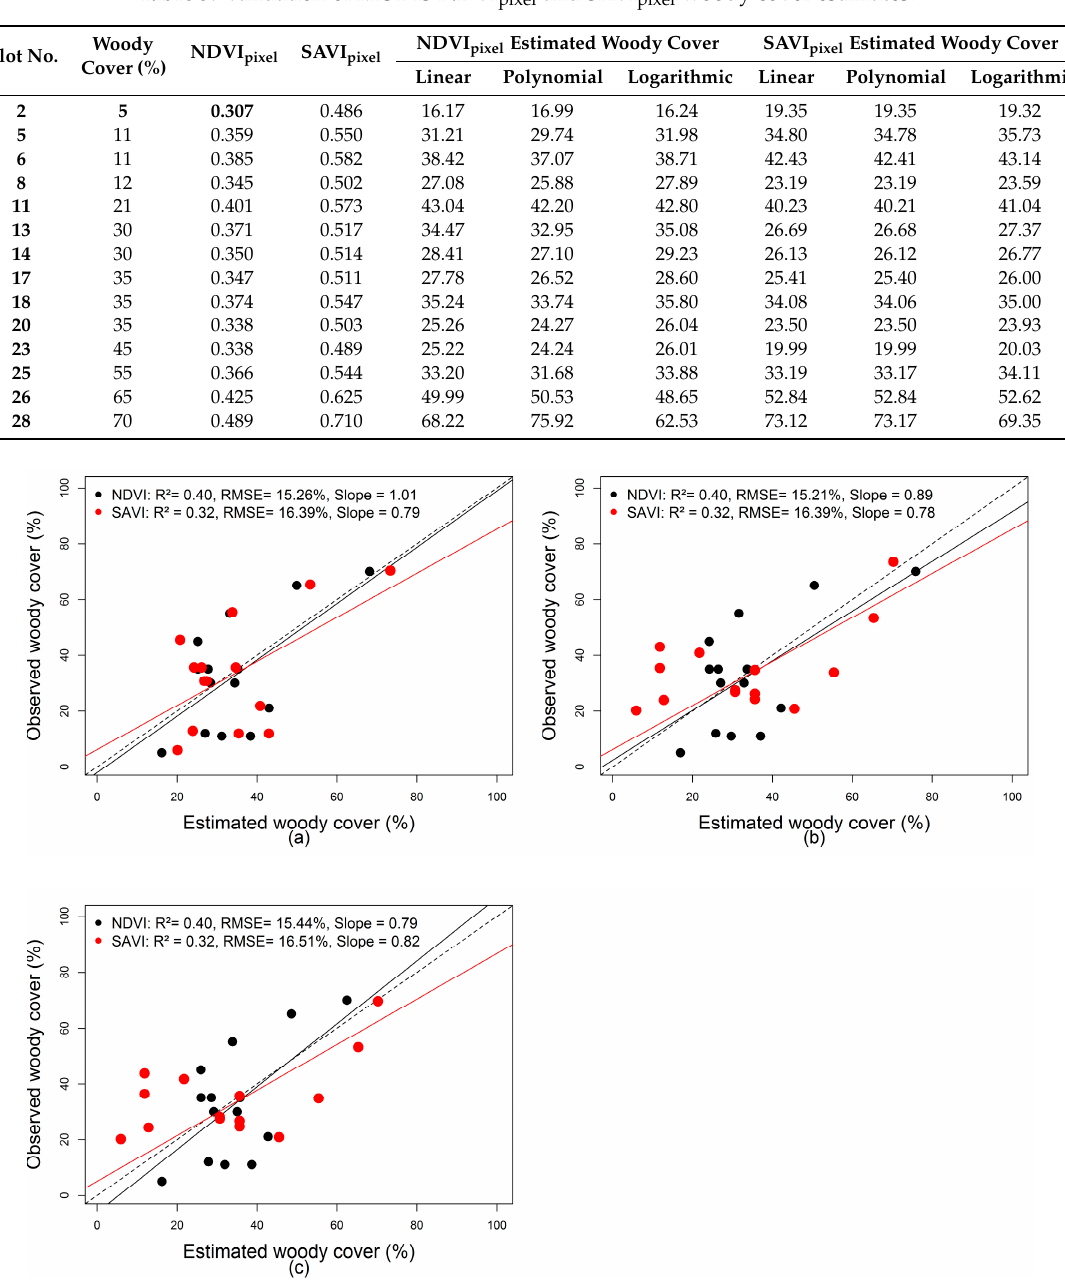
Figure 7. Validation of woody cover estimates derived with NDVI pixel and SAVI pixel using regression analyses, ( a ) with simple linear; ( b ) polynomial; ( c ) logarithmic regressions.